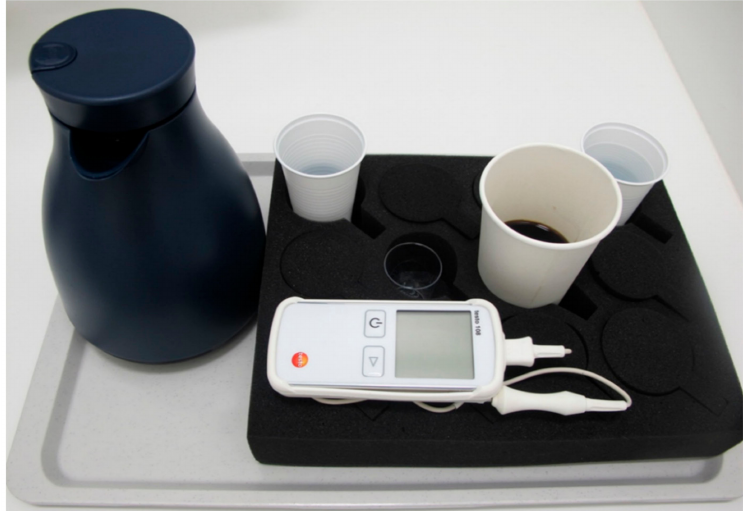
Figure 1. Experimental set-up provided to each participant. The isolation cup contains 150 mL of coffee at 60 ◦ C and the thermos flask coffee at 93 ◦ C. The small 40 mL beaker cup is used to gradually add the hot coffee. Two further cups with cold water for spilling if required and an empty cup for spitting are provided. The digital thermometer was used to measure the temperature in each tasting step.